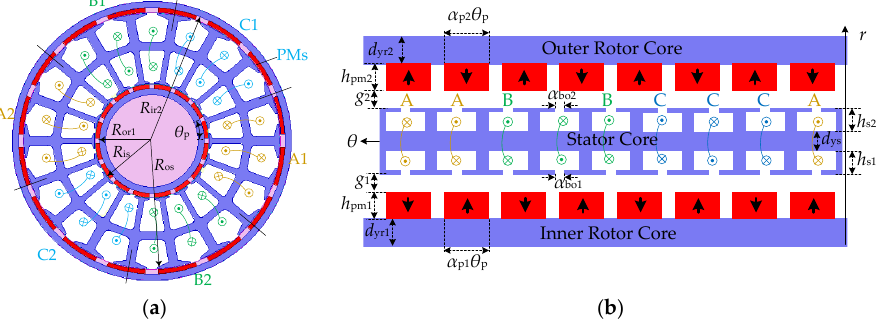
Figure 1. Configuration and linear topology of the proposed dual rotor radial flux (DRRF) wind generator: ( a ) Configuration; ( b ) Linear topology.